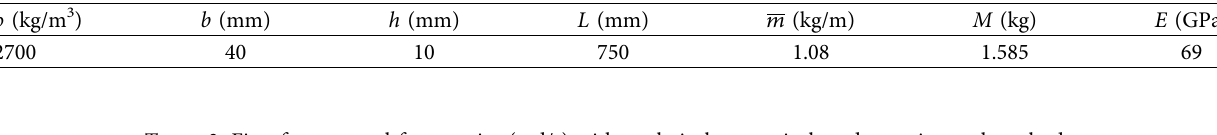
Table 1: Geometrical and material properties of the beam.